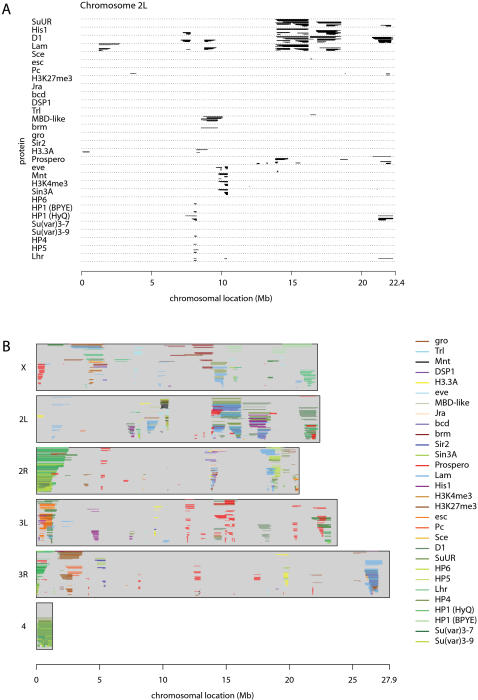
BRICK locations for all tested proteins.A) BRICKs on chromosome arm 2L. BRICKs smaller than 100 probed genes are shown for all analyzed proteins. The proteins are ordered by hierarchical clustering, with proteins that have the strongest overlapping domains closest together in the figure. B) Combined overview of the BRICKs for all proteins on all chromosome arms. BRICKs of different proteins are color-coded as indicated. Vertical position corresponds to the number of genes contained in the BRICK. Note that a substantial part of the Drosophila genome (∼50%) is covered by at least one BRICK.